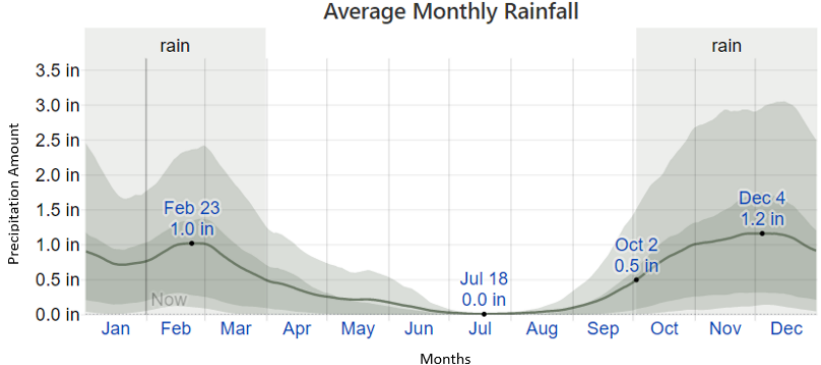
Figure 5. Annual rainfall distribution in Porto Santo. (Source: Madeira Regional Delegation of the Meteorological Institute).